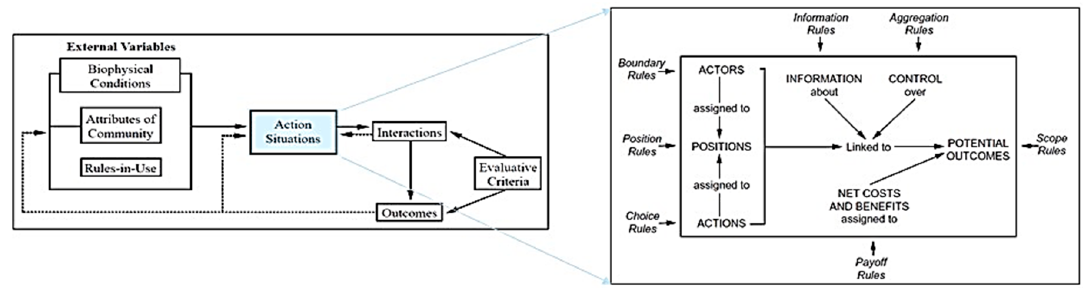
Figure 1. Institutional Analysis Framework and analysis of the action situations element (adapted from [22,24].